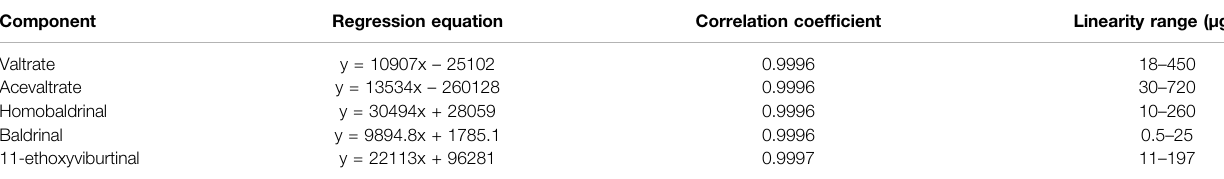
TABLE 3 | Regression equations and correlation coef fi cients of fi ve components in ZZX extract.